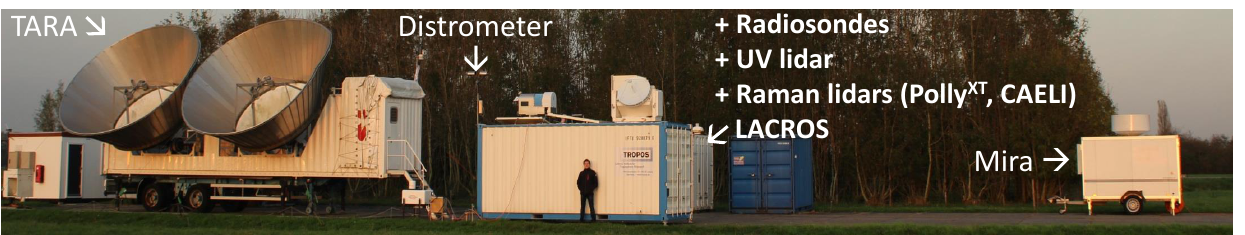
Figure 1. Measurement setup of the ACCEPT campaign at CESAR. The arrows point on the TARA radar (radar on the left), the disdrometer that is mounted on the LACROS container, and the vertical pointing Mira cloud radar (35GHz). Complementary instruments of ACCEPT are listed but not visible on this